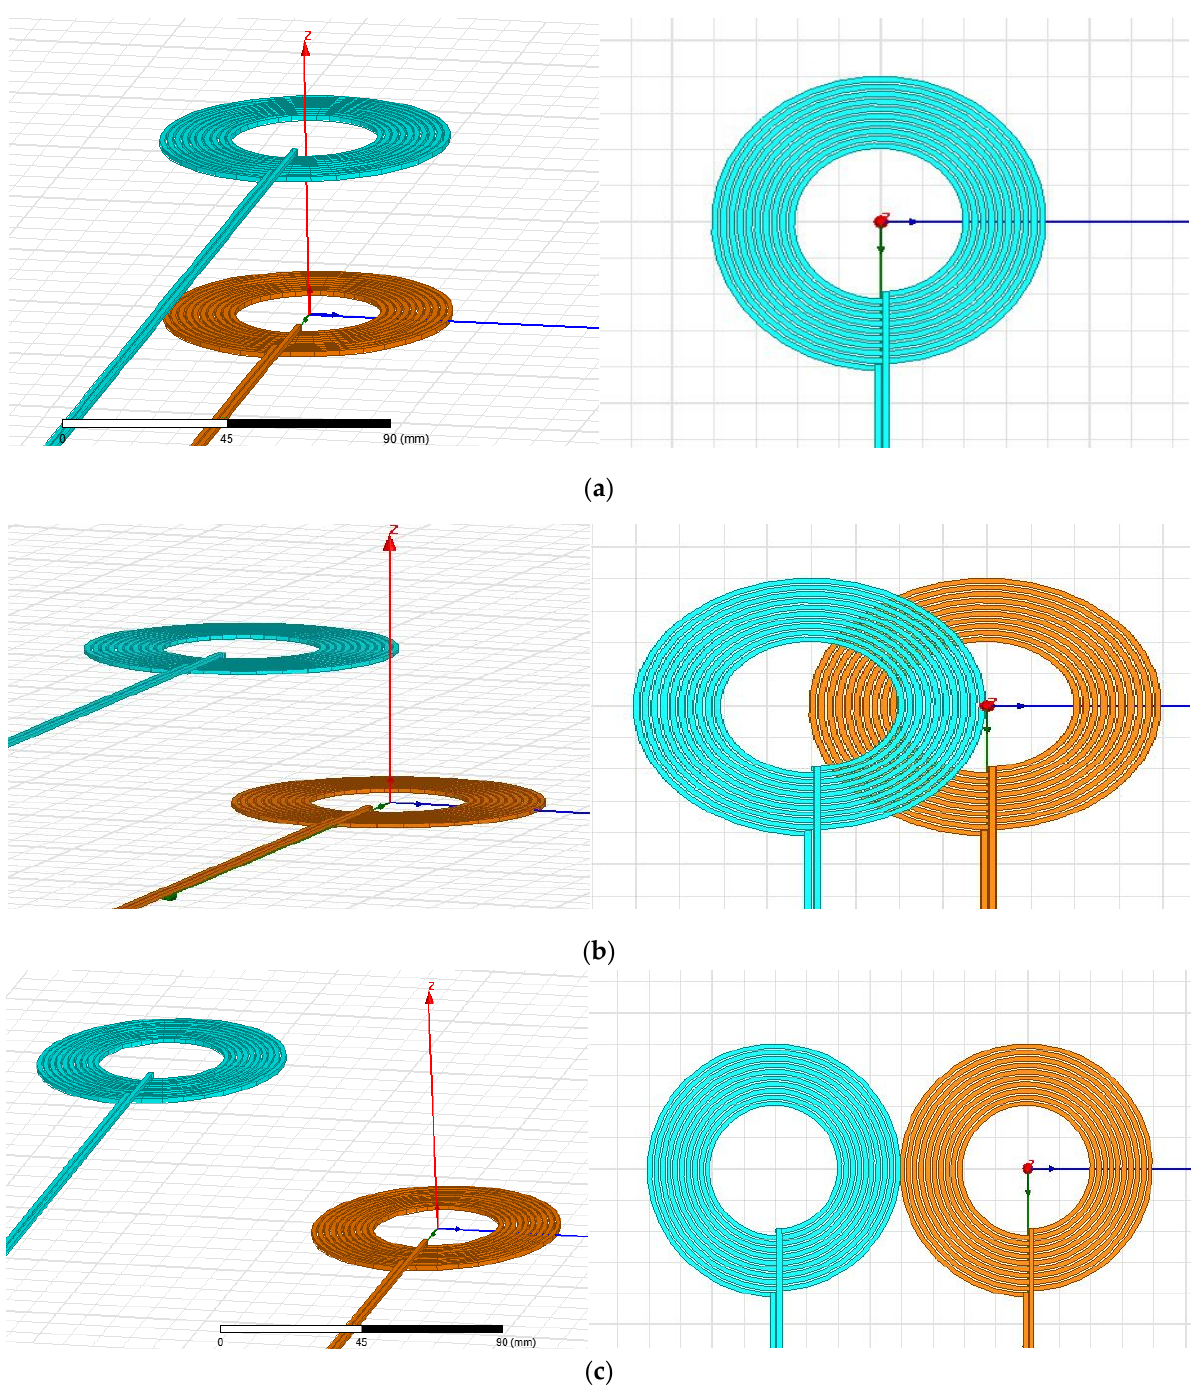
Figure 7. Reference coil model in Ansys Maxwell: ( a ) identical, ( b ) crisscrossed, ( c ) far apart. The primary and the secondary side coil models were designed using the Maxwell tool. The distance between the two-spool axis is variable, and then, the magnetic field simulations were applied for three different cases, as seen in Figure 7. In the first case, Figure 7a, shows the results of the horizontal coil offset, which is equal to 90%. In this study, to simplify the analysis of the system, the WPT consists of two identical circulating coils. Figure 8 shows the three cases of coil pattern circulating for a gap equal to 100 mm.